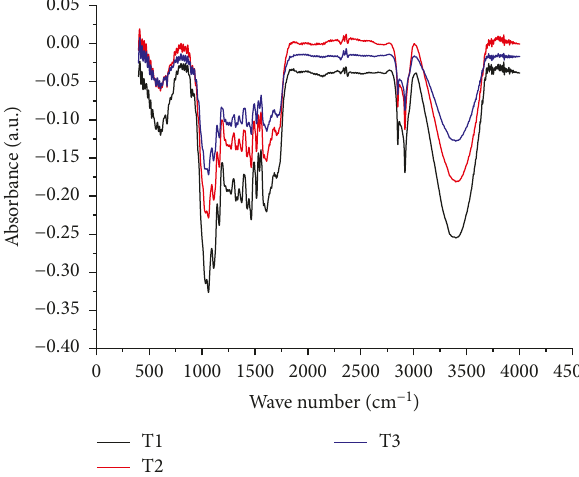
Figure 6: The FTIR spectra of specimens with various initial MC levels, heat treated at 220 ° C, and infested by the white rot for 4 weeks: (T1) 30% MC, (T2) 15% MC, and (T3) 5%